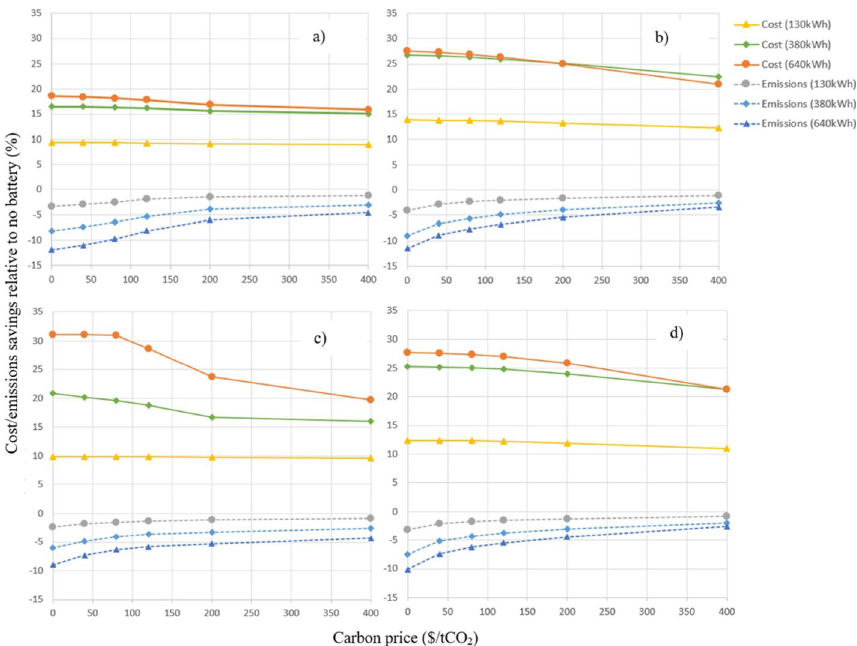
wholesale tariff scenario and 150 kW